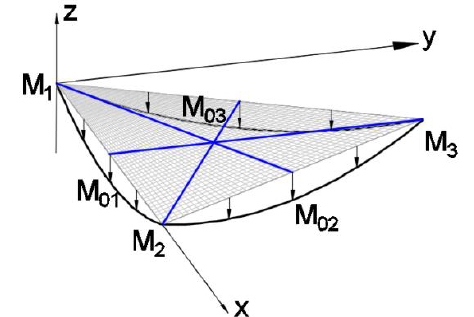
Fig. 13. 2 nd step of the knitted mesh fabric